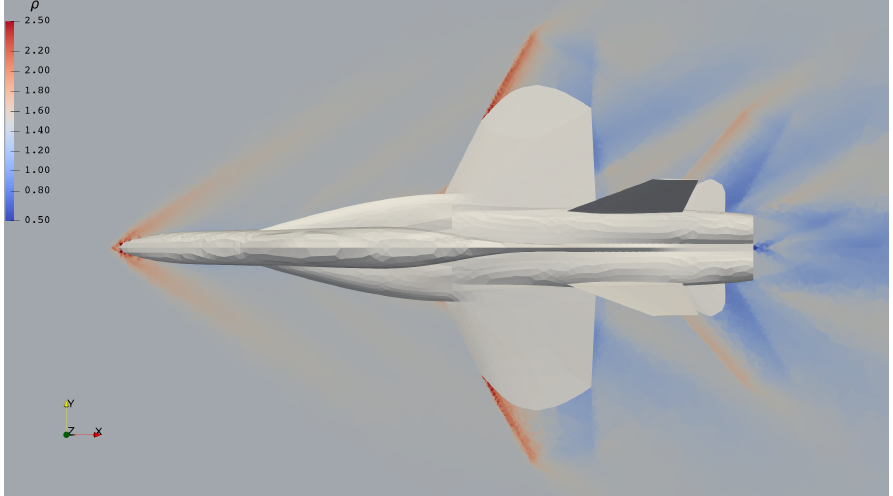
Figure 26. Comparison between the third-order solution (upper half) and the first-order solution (lower half) of Problem 6 on the z = 0 surface (top view).